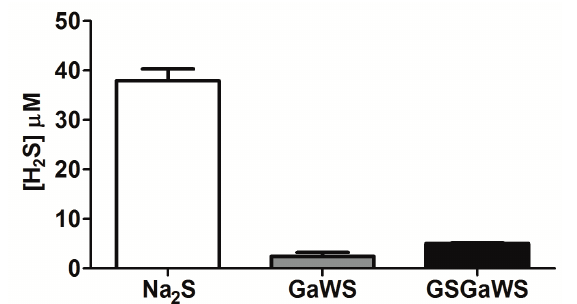
Figure 3. H 2 S production by 25 μ L of GaWS (0.8 mg) and GSGaWS (1.1 mg) cold extracts in the absence of reductant after 30 min of incubation at 37 °C, and a 52 μ M Na 2 S solution was used as a reference.